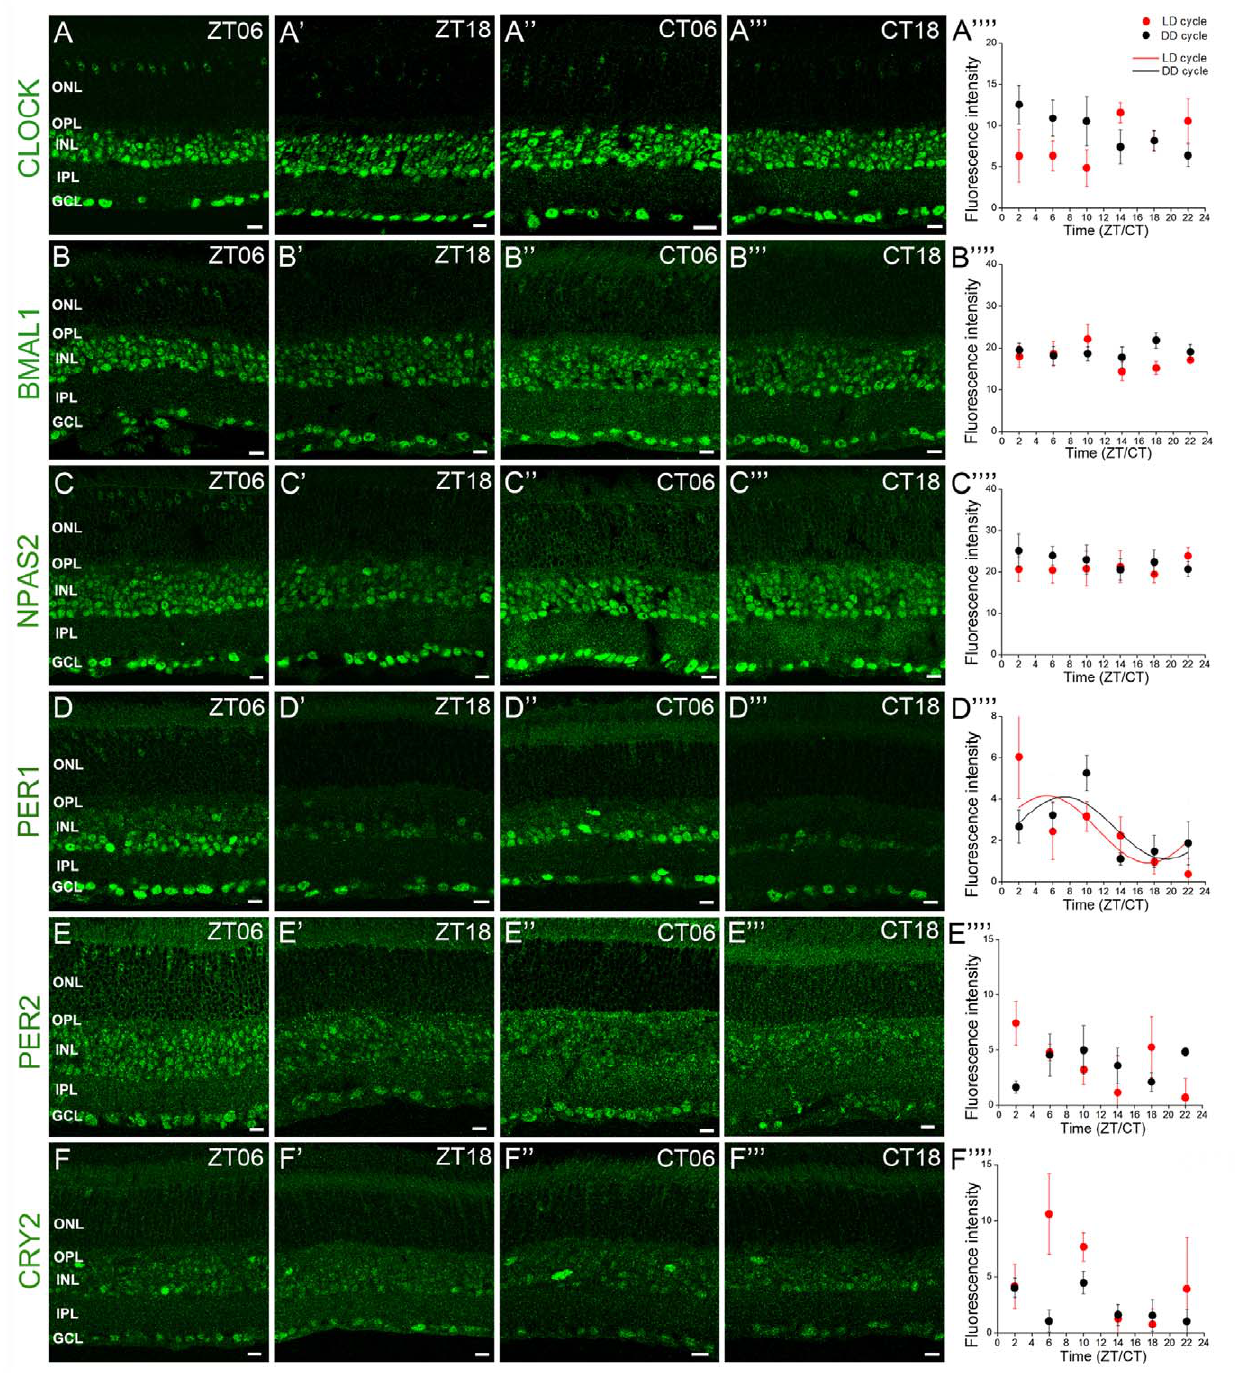
Figure 2. Expression of the six core mammalian circadian clock proteins CLOCK, BMAL1, NPAS2, PER1, PER2 and CRY2 in mouse retina during LD and DD cycles. Typical examples of vertical sections of C57Bl/6 mouse retinas collected in the middle of the day (ZT06; A–F ) or subjective day (CT06; A’’–F’’ ) or middle of the night (ZT18; A’–F’ ) or subjective night (CT18; A’’’–F’’’ ) are illustrated for CLOCK ( A–A’’’ ), BMAL1 ( B–B’’’ ), NPAS2 ( C–C’’’ ), PER1 ( D–D’’’ ), PER2 ( E–E’’’ ), and CRY2 ( F–F’’’ ). Optical sections 3 6 0.4 m m. Bar is 10 m m. Temporal expression profiles of CLOCK, BMAL1, NPAS2, PER1, PER2, and CRY2 in mouse retinal sections under LD and DD conditions ( A’’’’–F’’’’ ). Mouse retinas were collected every 4 h during a LD cycle or a DD cycle, and clock protein expression was quantified by measuring the mean fluorescence per section within a squared area whose upper and lower boundaries were the outer and inner limiting membranes, respectively (see Materials and Methods for details). COSINOR regression was performed only when variations in clock protein expression with time of day were detected (one-way ANOVA; P , 0.05). Note that only PER1 expression is significantly rhythmic under either LD or DD conditions ( D’’’’ ). Each data point represents the mean fluorescence/section + / 2 SEM of 5/6 animals (5 pictures from 3–4 sections/animal). ONL: outer nuclear layer; OPL: outer plexiform layer; INL: inner nuclear layer; IPL: inner plexiform layer; GCL: ganglion cell layer.